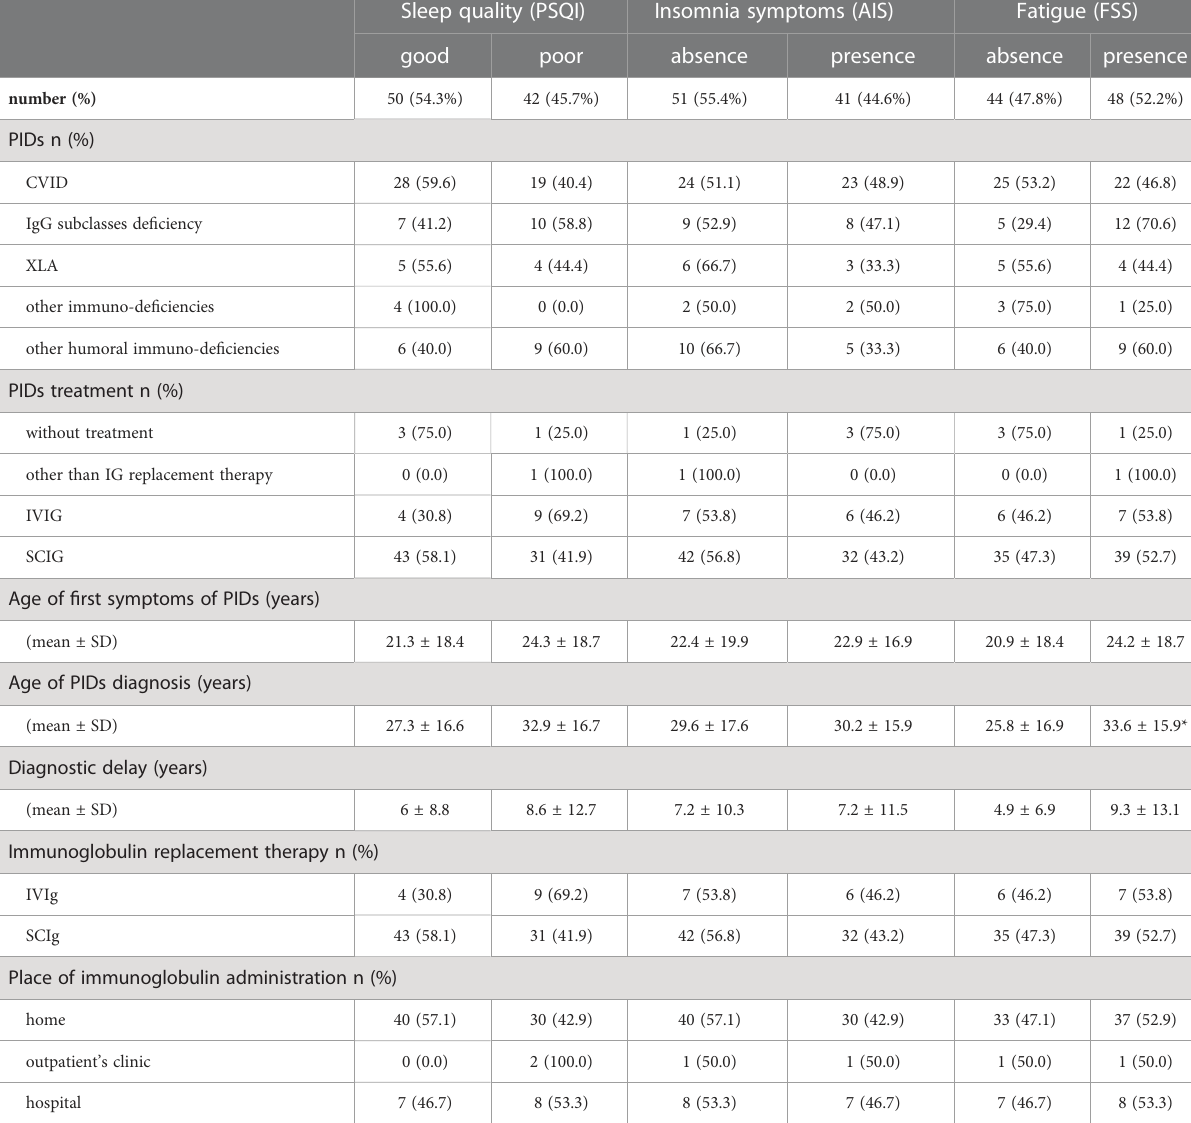
TABLE 5 Comparison of patients with good or poor sleep quality (PSQI), absence or presence of insomnia symptoms, and absence or presence of fatigue symptoms according to primary immunode fi ciencies